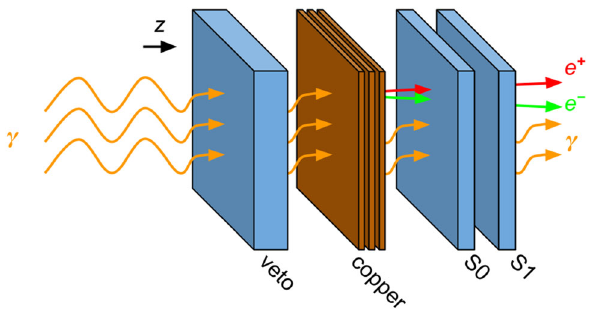
Fig. 5 Scheme of the active photon conversion system. The veto scin- tillator is also